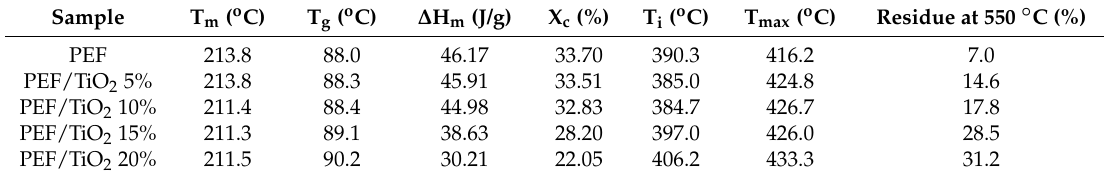
Table 1. DSC data ( ∆ H 0 m = 137 J/g [42]), T i (initiation of degradation temperature), T max (temperature